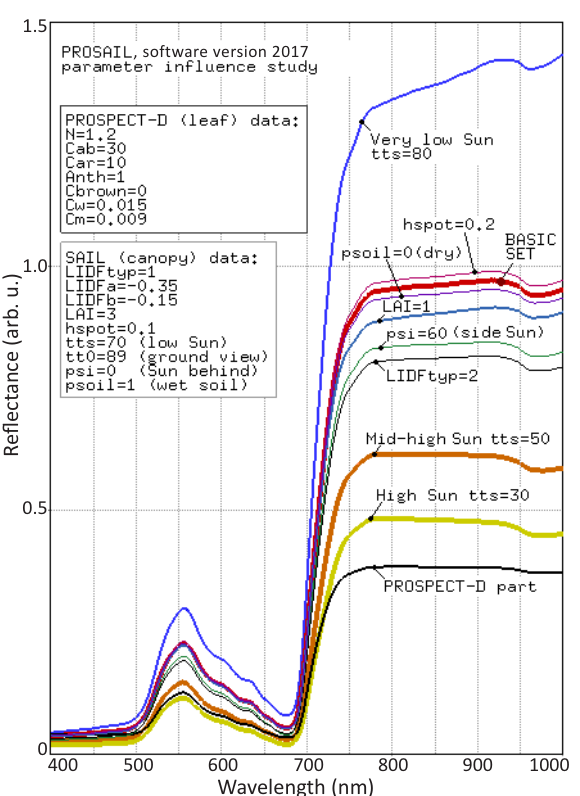
Fig. 3. Additional study of leaf area/inclination and light ­ ing/observation factor influences on the green vegetation reflectance spectra with the state­of­the­art canopy level bio ­ physical model PROSAIL